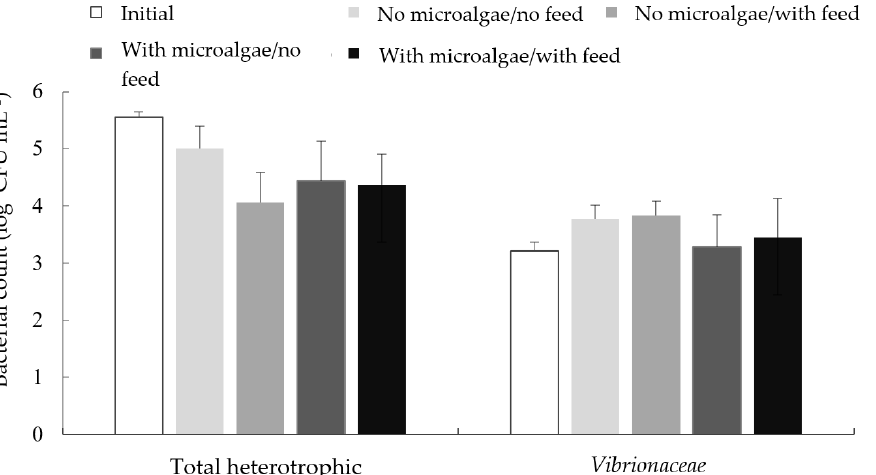
Figure 2. Total heterotrophic bacteria and Vibrio spp. counts in the water of a Pacific white shrimp ( Litopenaeus vannamei ) and Nile tilapia ( Oreochromis niloticus ) integrated culture using biofloc technology for 62 days, in which the addition or no addition of both microalgae and fish feed was evaluated in a factorial design.